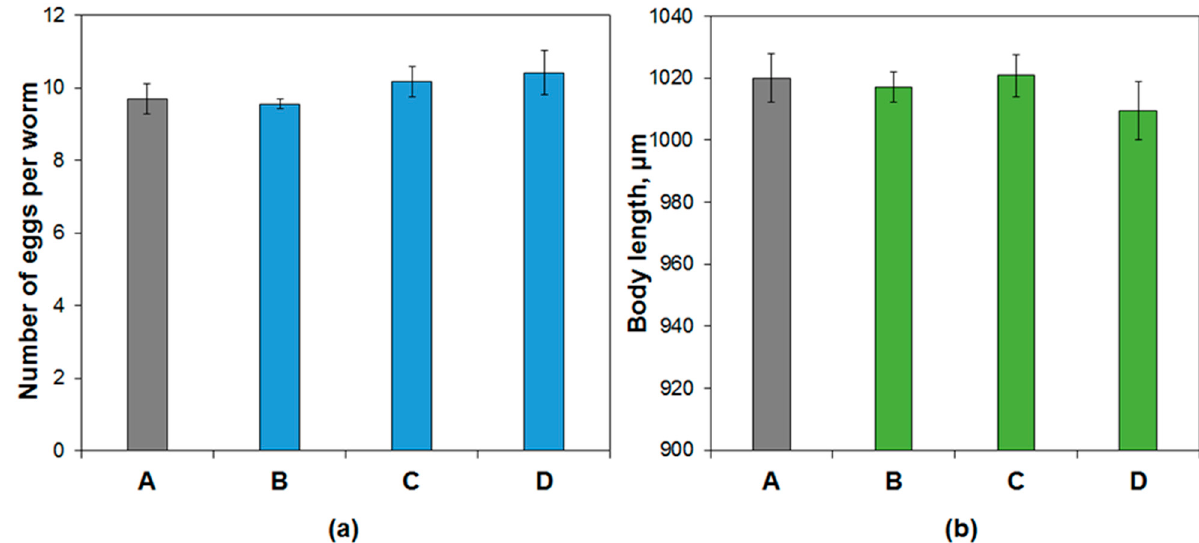
Figure 6. ( a ) The reproductive ability and ( b ) the body length of Caenorhabditis elegans after incubation with: A—pristine halloysite, B—CdS/HNT-Azine, C—Cd 0.7 Zn 0.3 S/HNT-Azine, D—CdS/HNT-NH 2 . halloysite, B—CdS/HNT-Azine, C—Cd 0.7 Zn 0.3 S/HNT-Azine, D—CdS/HNT-NH 2